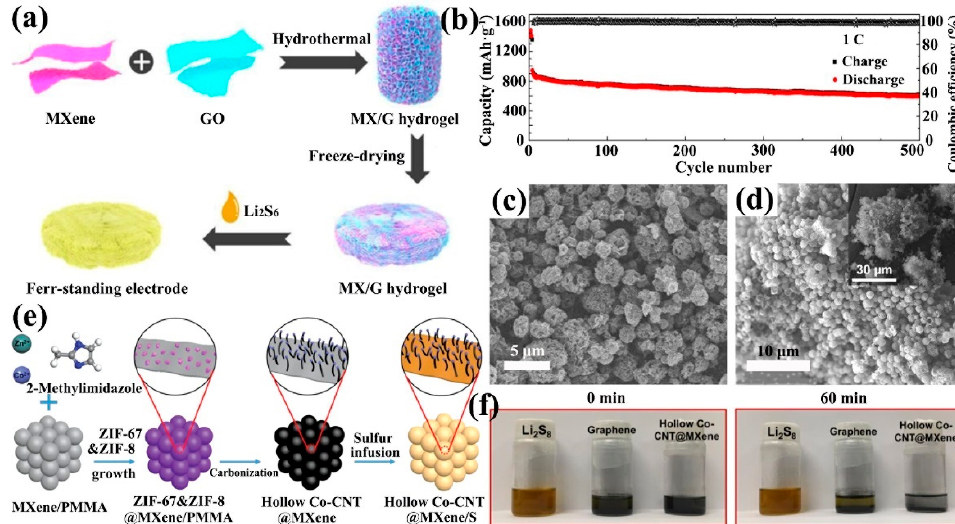
Figure 8. Preparation of MX/G aerogel sulfur cathodes ( a ) and their testing at 1 C for 500 cycles ( b ) [101]. Copyright 2019, Royal Society of Chemistry. ( c ) SEM image of N-Ti 3 C 2 @CNT microspheres [102]. Copyright 2019, Springer. SEM image of hollow Co-CNT@MXene microspheres ( d ) and the fabrication process of their supported sulfur cathodes ( e ). The adsorption test of LiPSs by hollow Co-CNT@MXene micro- spheres, after 60 min the LiPSs solution of hollow Co-CNT@MXene microspheres became obviously clearer than the LiPSs solution of graphene ( f ) [103]. Copyright 2020,